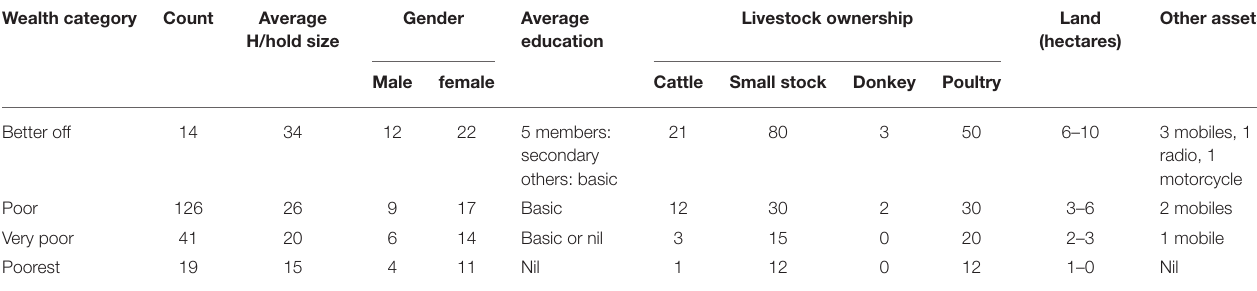
TABLE 1 | Socio-demographic features of participating households in